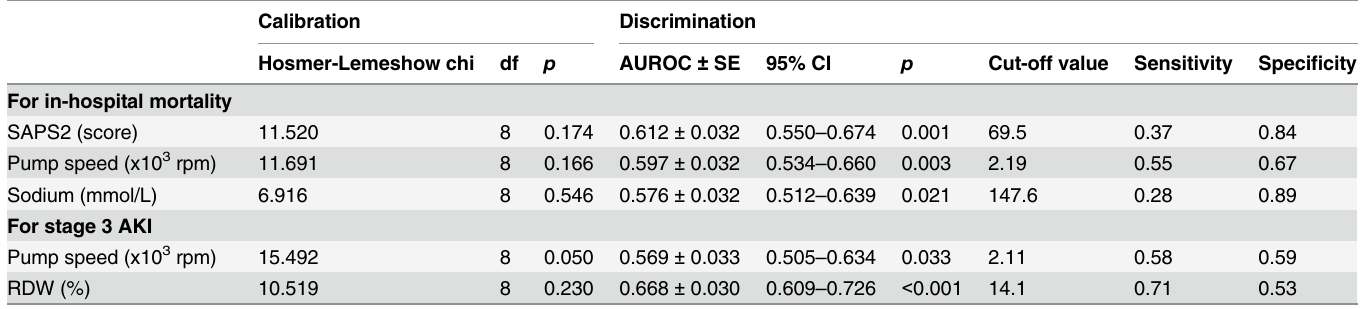
Table 3. Calibration and discrimination analysis for in-hospital mortality and stage 3 AKI. Calibration